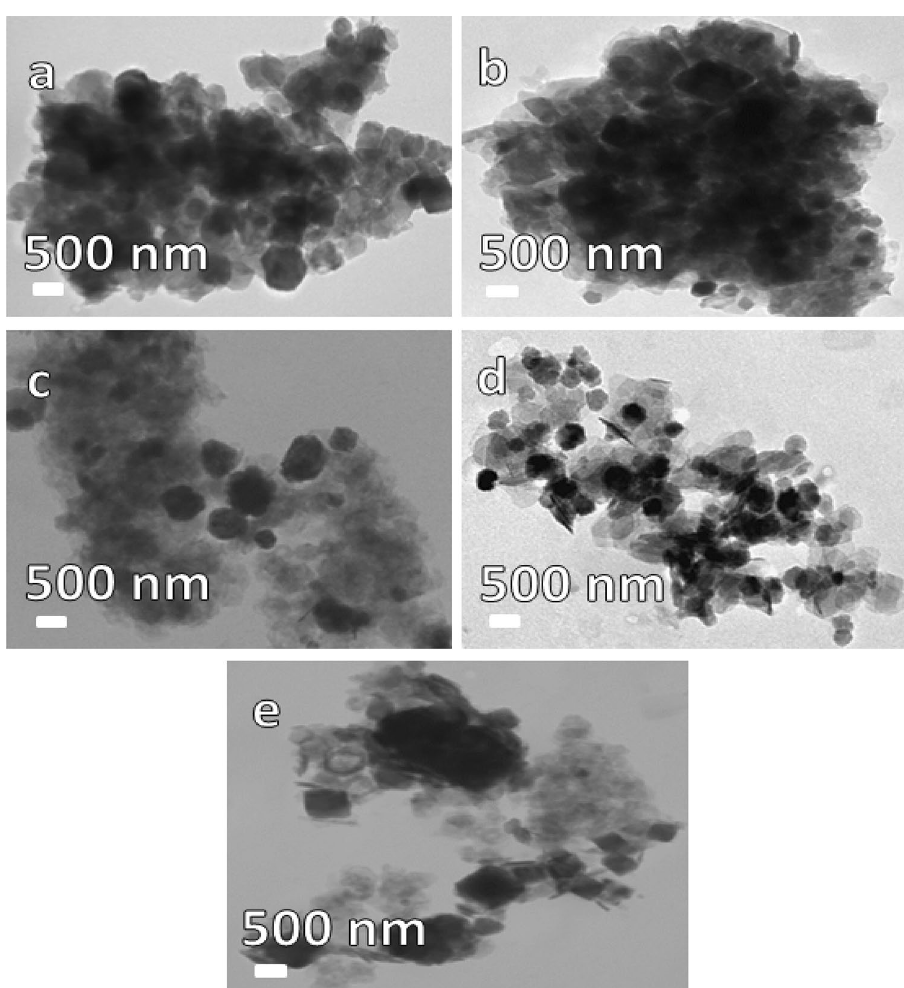
Fig. 3 TEM micrographs